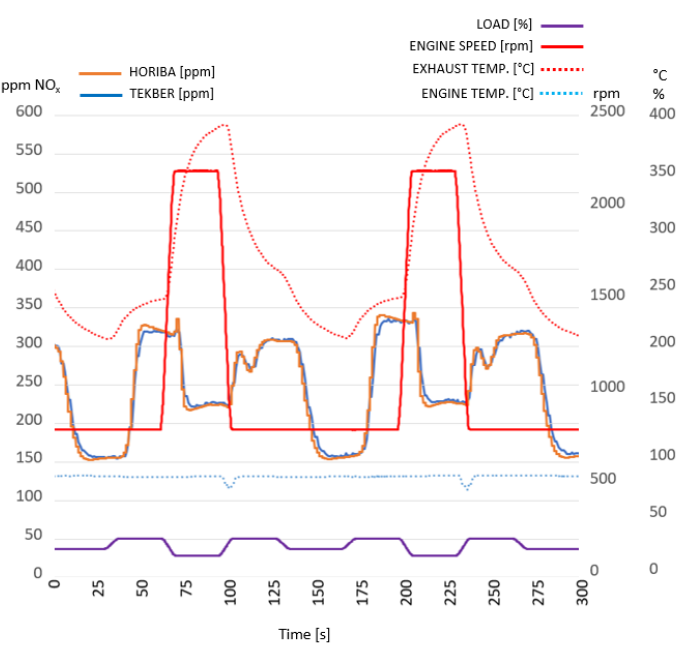
Figure 4. Sample of the Test without EGR and low load conditions.